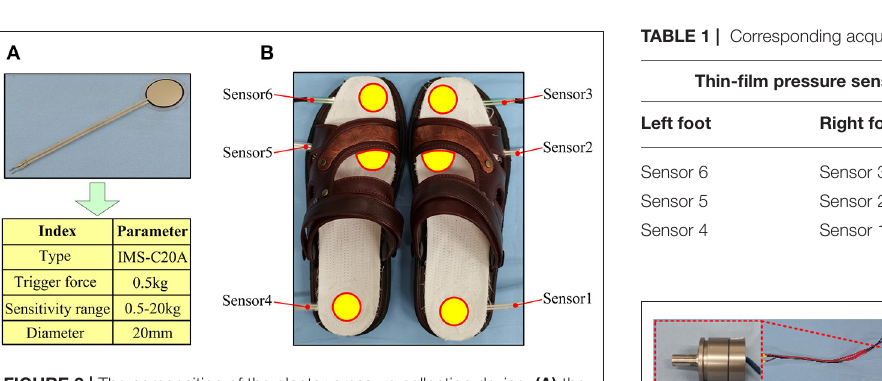
FIGURE 2 | The composition of the plantar pressure collection device; (A) the thin-film pressure sensor and its parameters, (B) the physical product of the plantar pressure collection device.